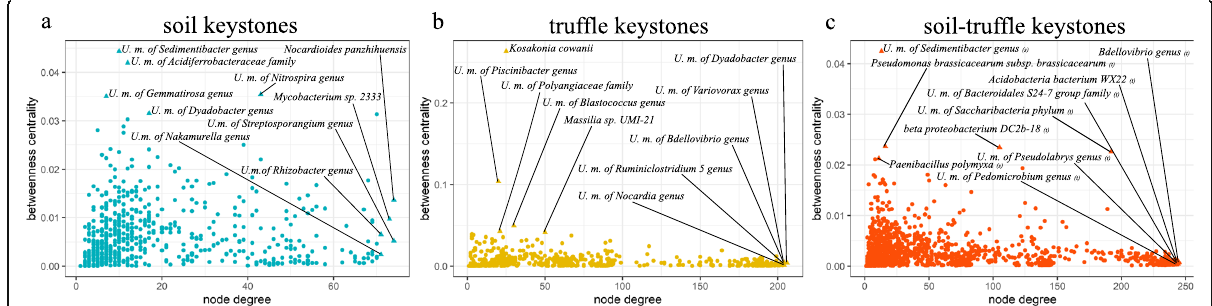
Fig. 6 Keystone species obtained from the network analysis. Nodes represent species that are shown agreeing to their centrality metrics (triangles indicate the top 5 keystone species based on node degree and betweenness centrality). Each node of a plot represents a species in the related network ( a for soil, b for truffle, and c for soil-truffle). Nodes are colored according to the network they belong to (blue for soil, yellow for truffle, and red for soil-truffle). Keystone species names are showed for some of the most relevant nodes of each network. In the soil-truffle network the apex beside of species name indicates the habitat in which the species was detected: (s) for soil and (t) for truffle